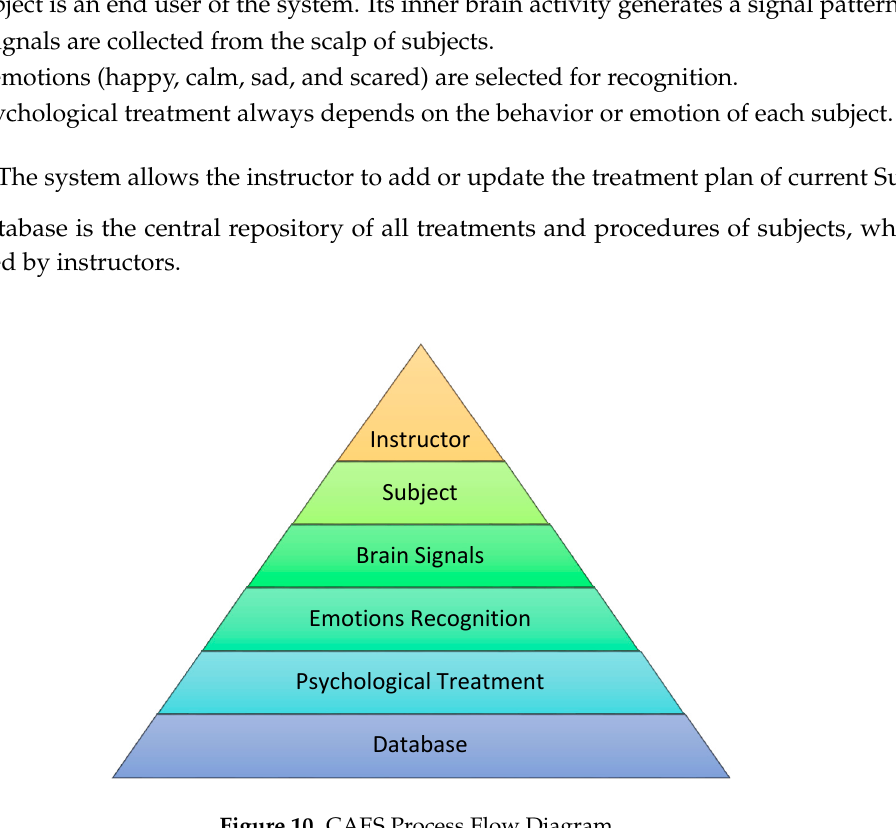
Figure 10. CAES Process Flow Diagram.